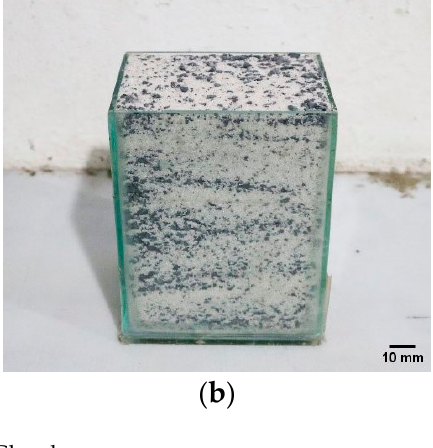
Figure 2. Aggregate composition. ( a ) Aggregates, ( b ) Glass box. Table 4. Cases of the aggregate